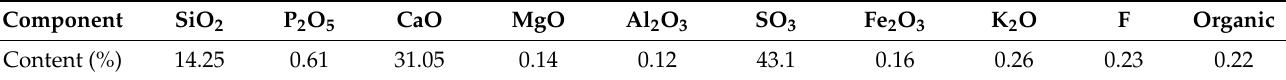
Table 1. Chemical composition of the phosphorous building